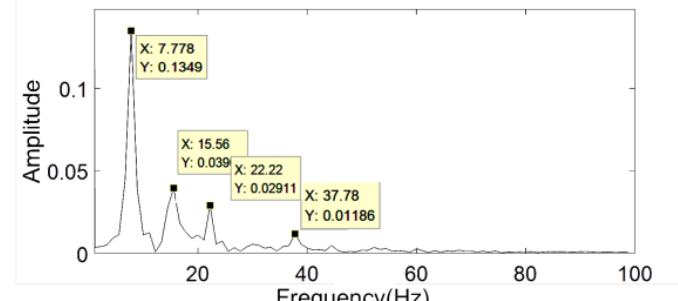
Figure 40. The influence of k ipll on i gd .